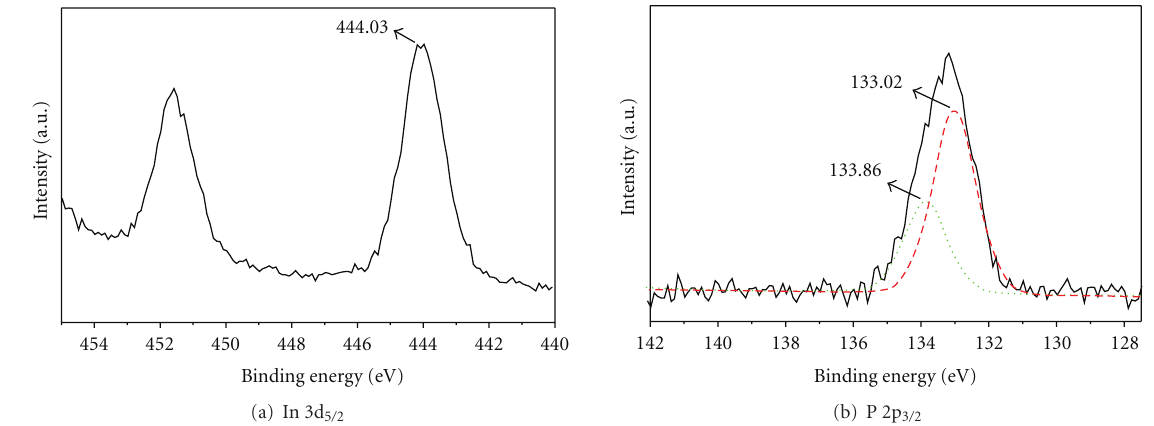
Figure 5: XPS analysis of 1.0 mol% In, P incorporated TiO 2 photocatalysts treated at 800 ◦ C; (a) In 3d and (b) P 2p spin orbital.